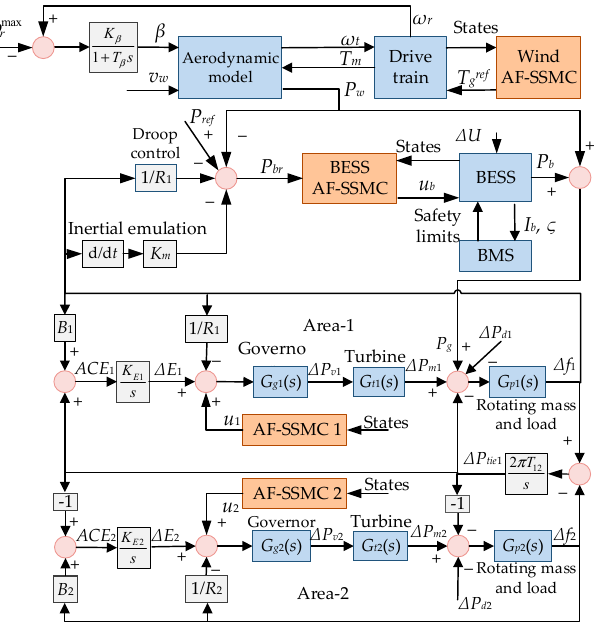
Figure 5. Hybrid power